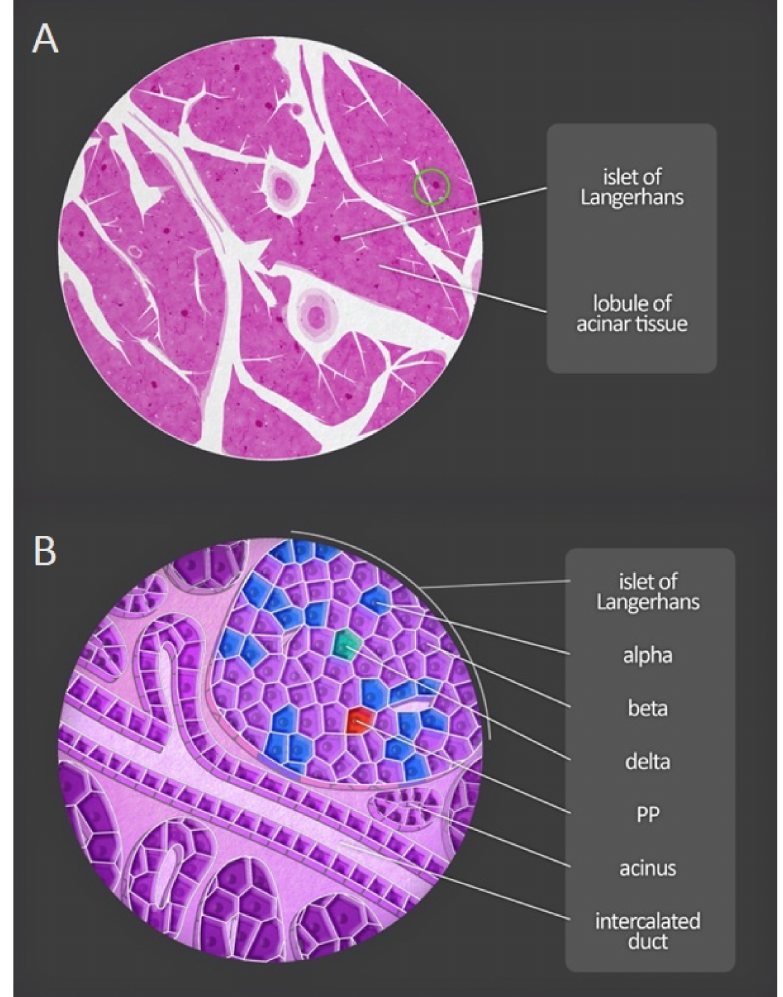
Figure 4. Microscopic anatomy of the human pancreas. ( A ) Magnification of a portion of the pancreas shows both lobules and pancreatic islets. ( B ) At greater magnification, acini and excretory ducts are visible. Different types of endocrine cells composing the pancreatic islets can be distinguished by immunofluorescent staining. PP—pancreatic polypeptide